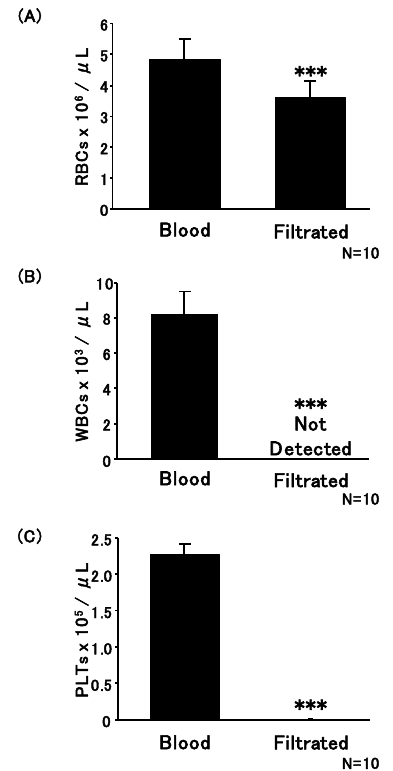
Figure 3. Evaluation of push column performance in the purification of erythrocytes from whole blood. The number of erythrocytes (red blood cells, A ), leucocytes (white blood cells, B ), and platelets (PLTs, C ) was analyzed before (left bars) and after (right bars) filtration of whole blood. *** p < 0.001 (Student’s t -test, n = 10).